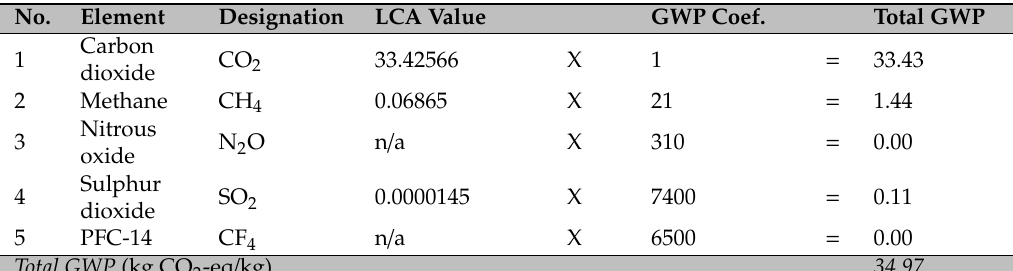
Table 14. Results for related gasses being aggregated into a single unit in terms of their impact as carbon dioxide equivalents for DR-HPF